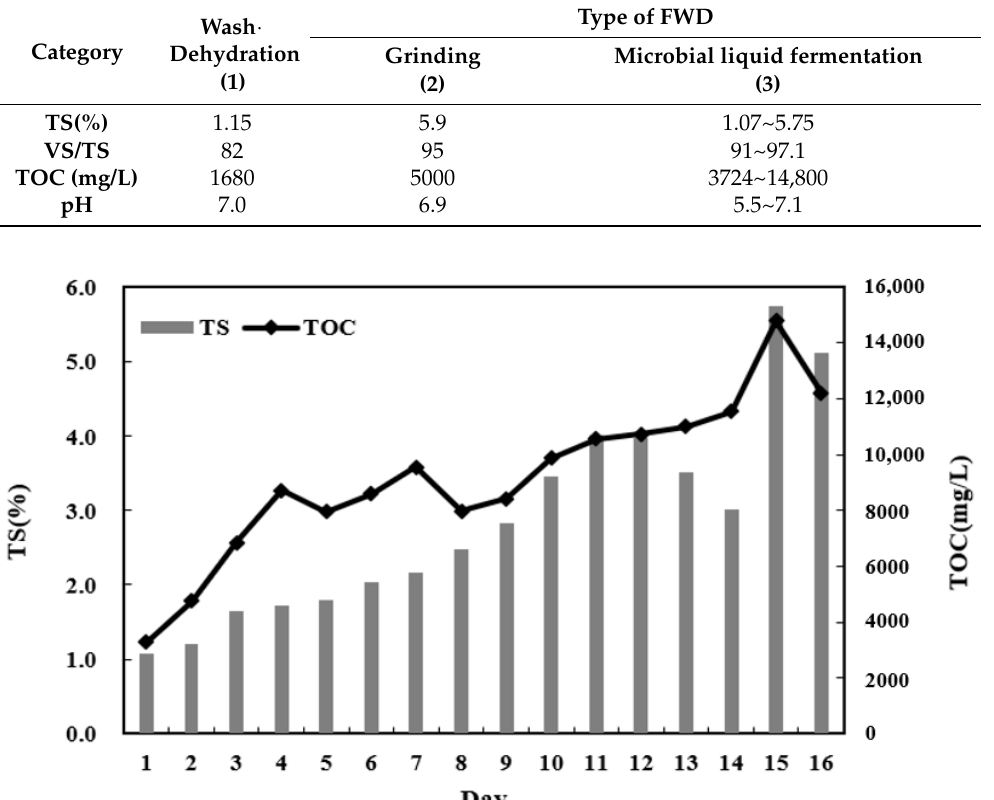
Figure 2. TS and TOC of wastewater from microbial liquid fermentation.